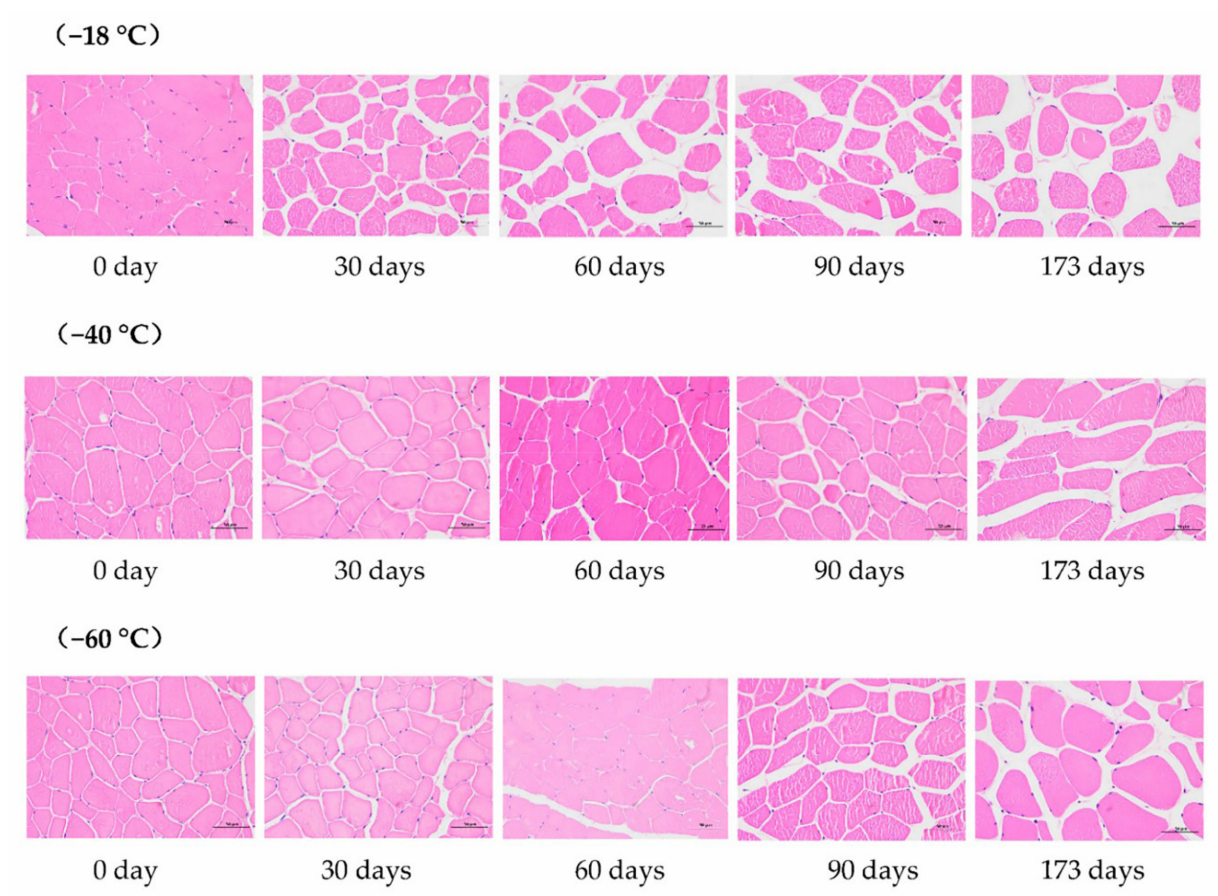
Figure 1. Effects of different freezing storage temperatures on ice crystal formation in snowflake beef ( n =